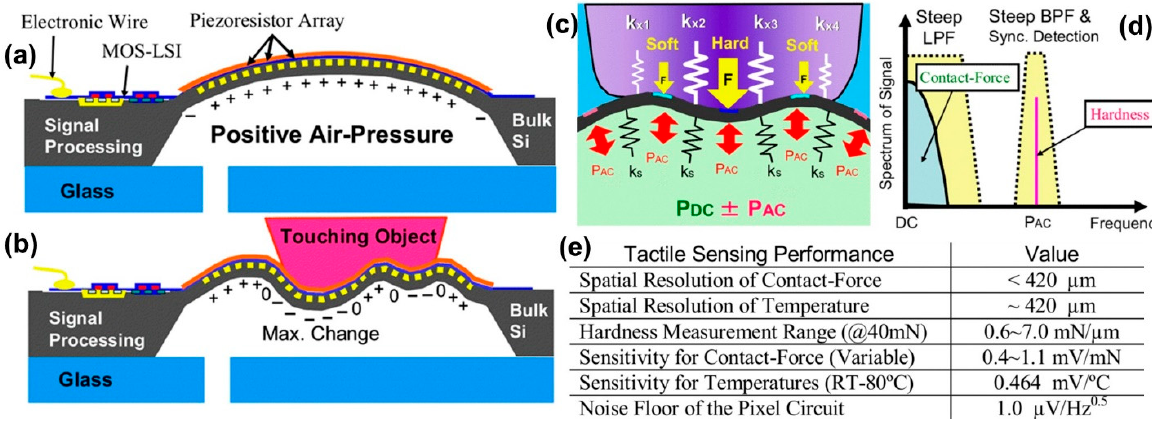
Figure 11. Cross-section and surface stress of the tactile imager, ( a ) before object contact, ( b ) after object contact. ( c ) Detection principle of distributed hardness using pressure vibration; ( c ) Repulsive force distribution for ± PAC depending on local hardness, ( d ) Power spectrums of piezoresistor signal. Contact-force signal appears as the average around DC, while hardness signal appears at PAC. ( e ) Summary of measured performances (10 μ m-thick sensing diaphragm). Reprinted/adapted with permission from Ref. [95]. Copyright 2007, IEEE.